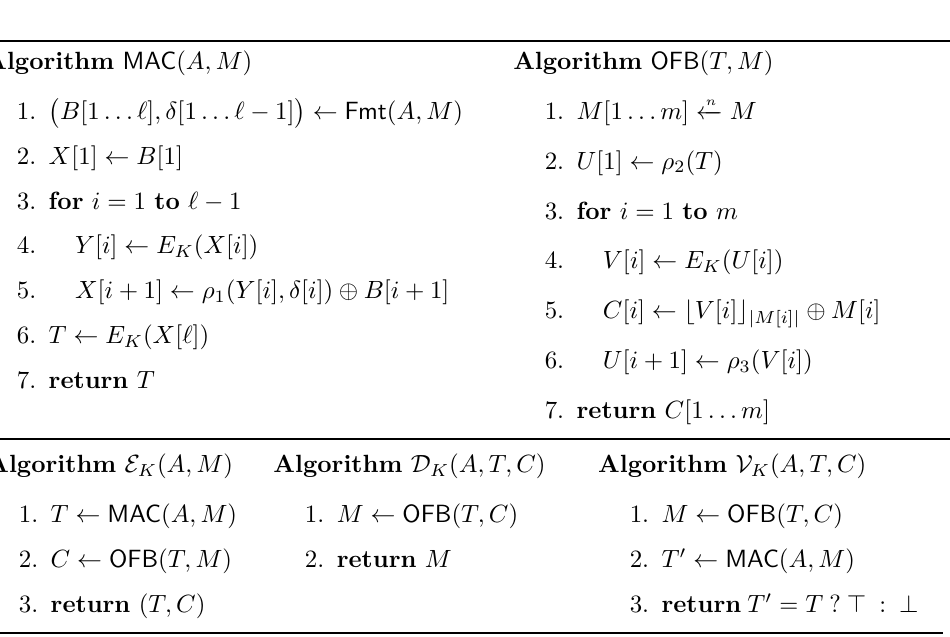
Figure 3: Encryption, decryption and verification algorithm of